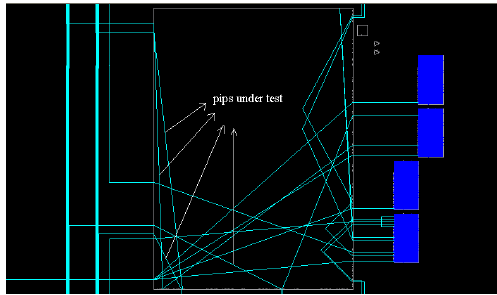
Figure 22. Details of PIPs under test in the oblique direction. Table 5. Summary of the configuration number & fault coverage in the oblique